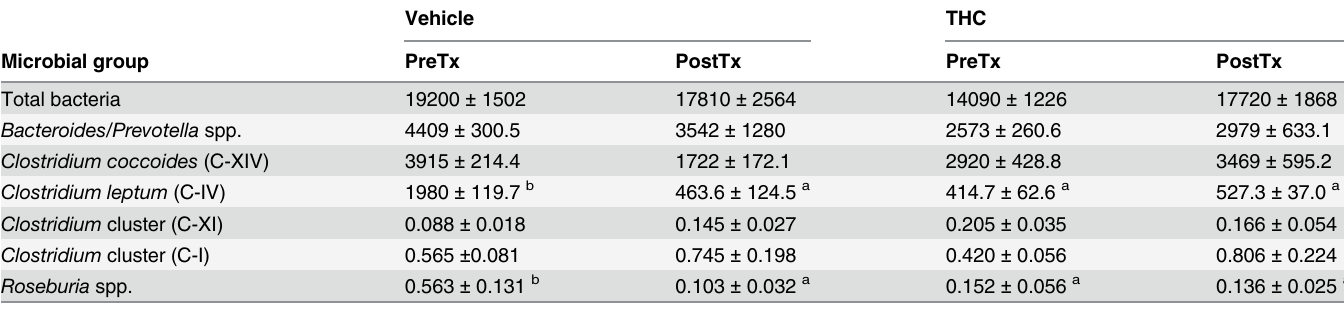
Table 1. Microbiota content in fecal matter of lean mice prior to (Pretreatment, PreTx), and following (Posttreatment, PostTx) chronic administra- tion of Δ 9 -tetrahydrocannabinol (THC) or vehicle. Vehicle